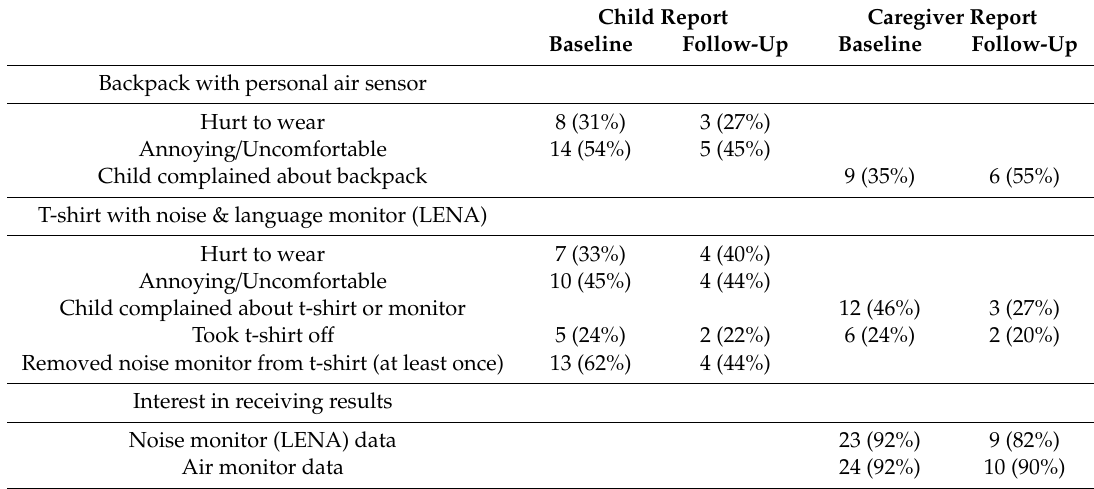
Table 3. Data from the child and caregiver compliance interview and